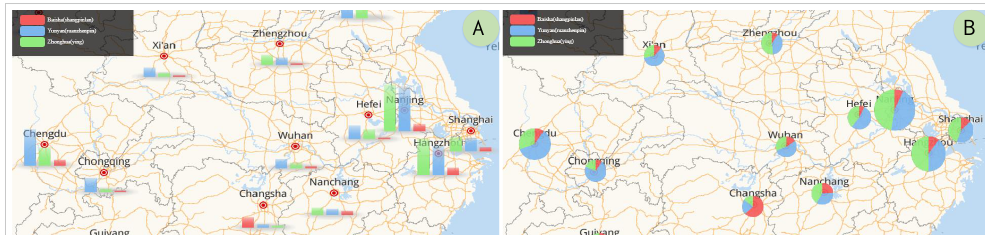
Figure 3. Comparative visualization. ( A ) Overlaying bar chart on the map. ( B ) Overlaying pie chart on the